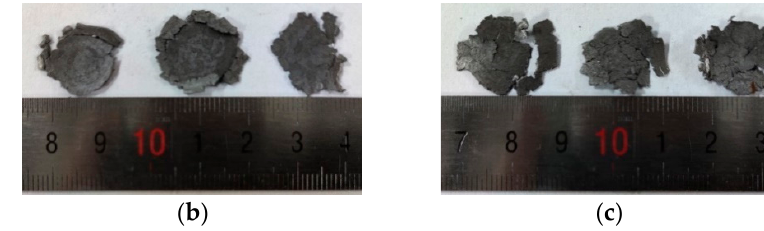
Figure 14. The recycled sample at different temperatures: ( a ) T = 100 °C; ( b ) T = 150 °C; ( c ) T = 200 °C.